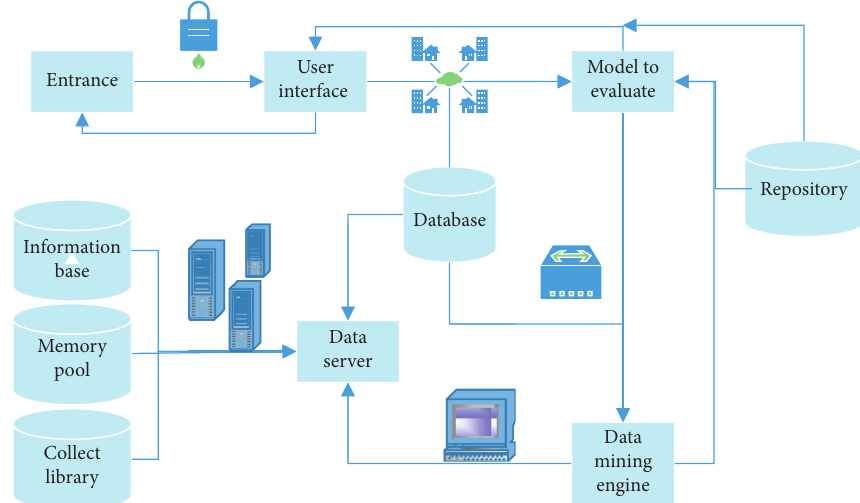
Figure 4: Typical data mining system structure diagram.